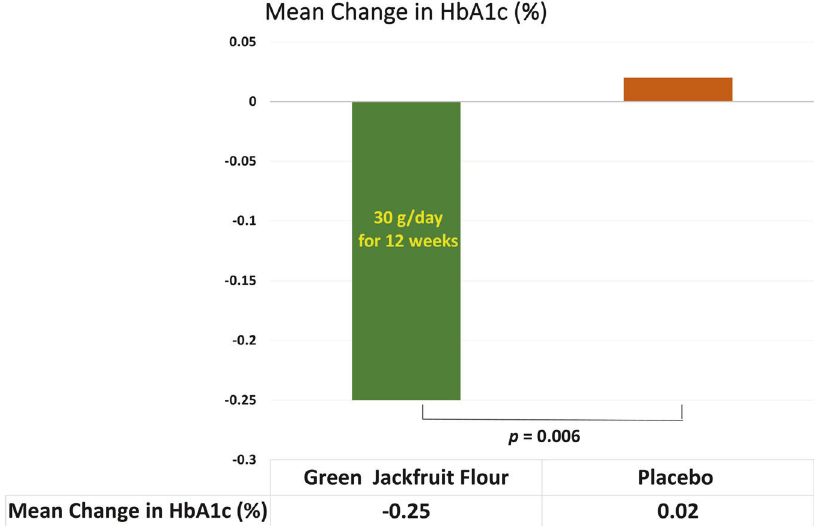
Fig. 2 Mean change in HbA1c from baseline to week 12 across both